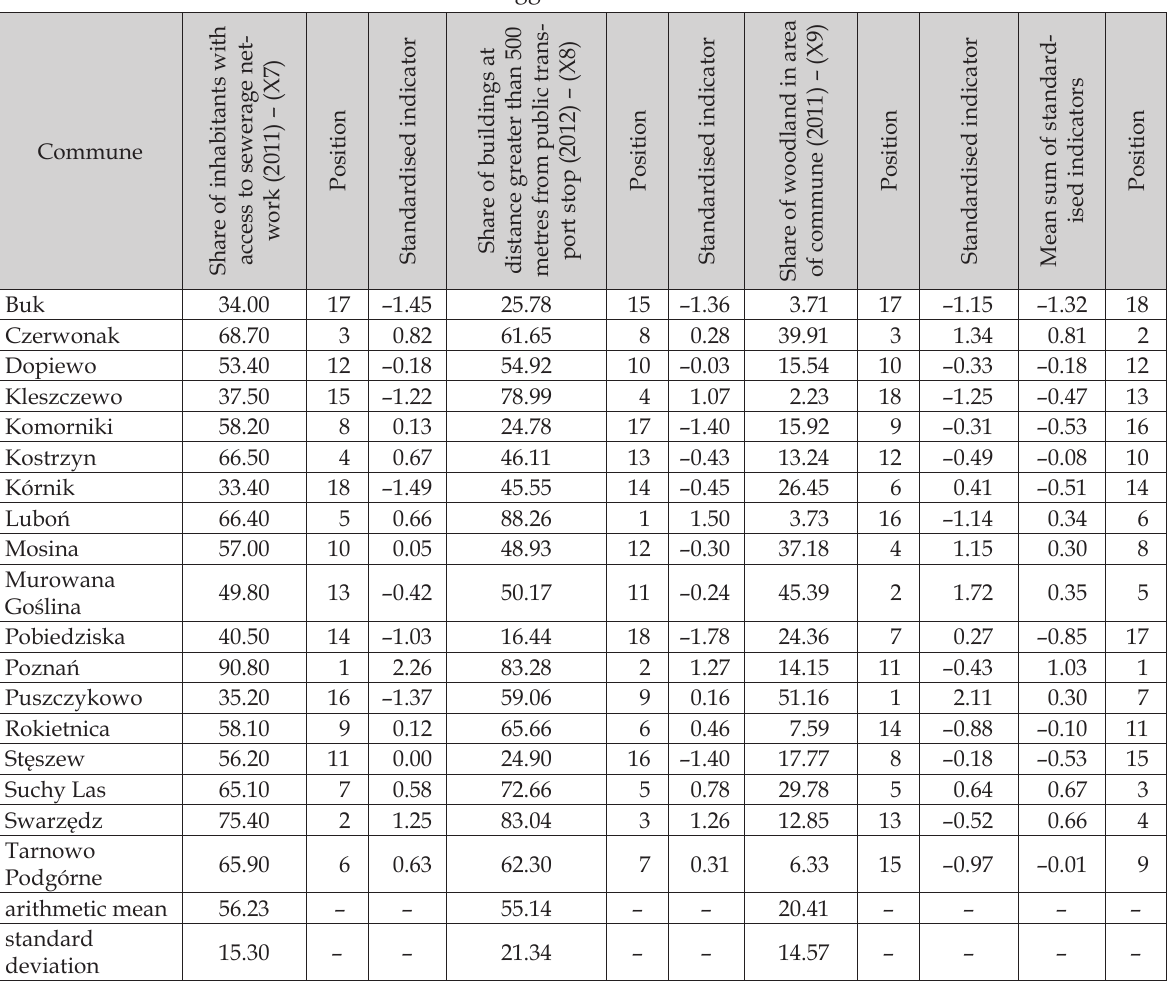
Table 3. Differences in the environmental determinants of the quality of life in the communes of the Poznań